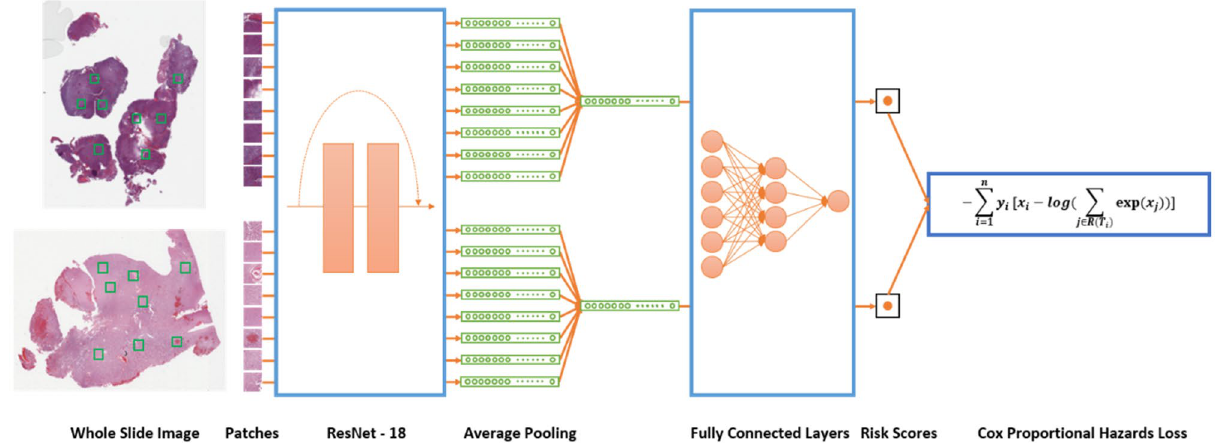
Figure 3. An overview of the deep learning pipeline for prognosis prediction. Patches of size 224 × 224 × 3 are randomly sampled from whole slide images at a 10 × magnification level. The ResNet-18 Convolutional Neural Network transformed each patch into a 512 × 1 vector. Average pooling is performed at the patient level. The patient level vectors then go through a two-layer fully connected network with a final output size of 1, which can be interpreted as risk scores. Cox proportional hazards loss is calculated using the risk scores with consideration of follow-up time and vital status. The gradient is calculated and backpropagated through the fully connected layers and the ResNet-18 layers to train the entire